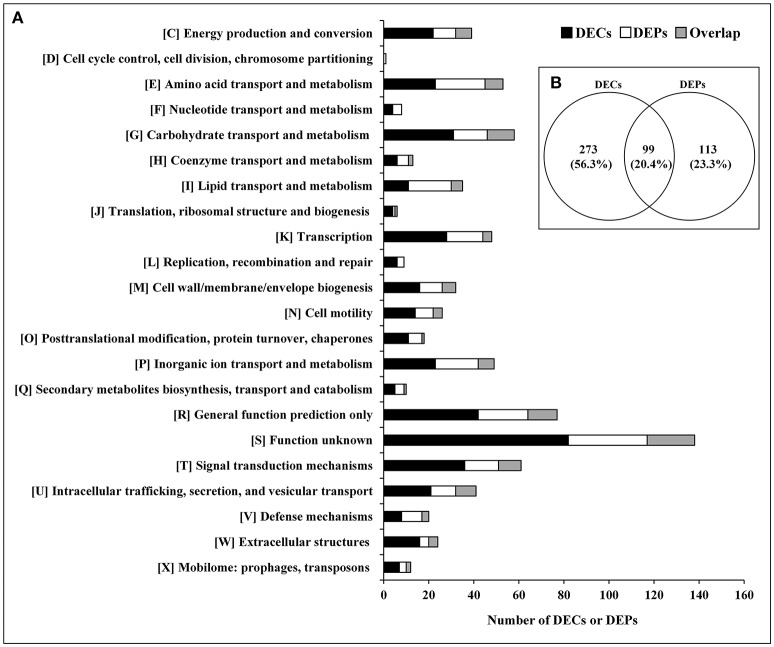
DECs and DEPs in the rpoS mutant in relation to the wild-type strain UK4. (A) Classification of the DECs, DEPs, and their overlap into individual functional groups (COGs C-X). (B) Venn diagram of DECs and DEPs. This figure was drawn using Venny 2.0 (http://bioinfogp.cnb.csic.es/tools/venny/index.html).